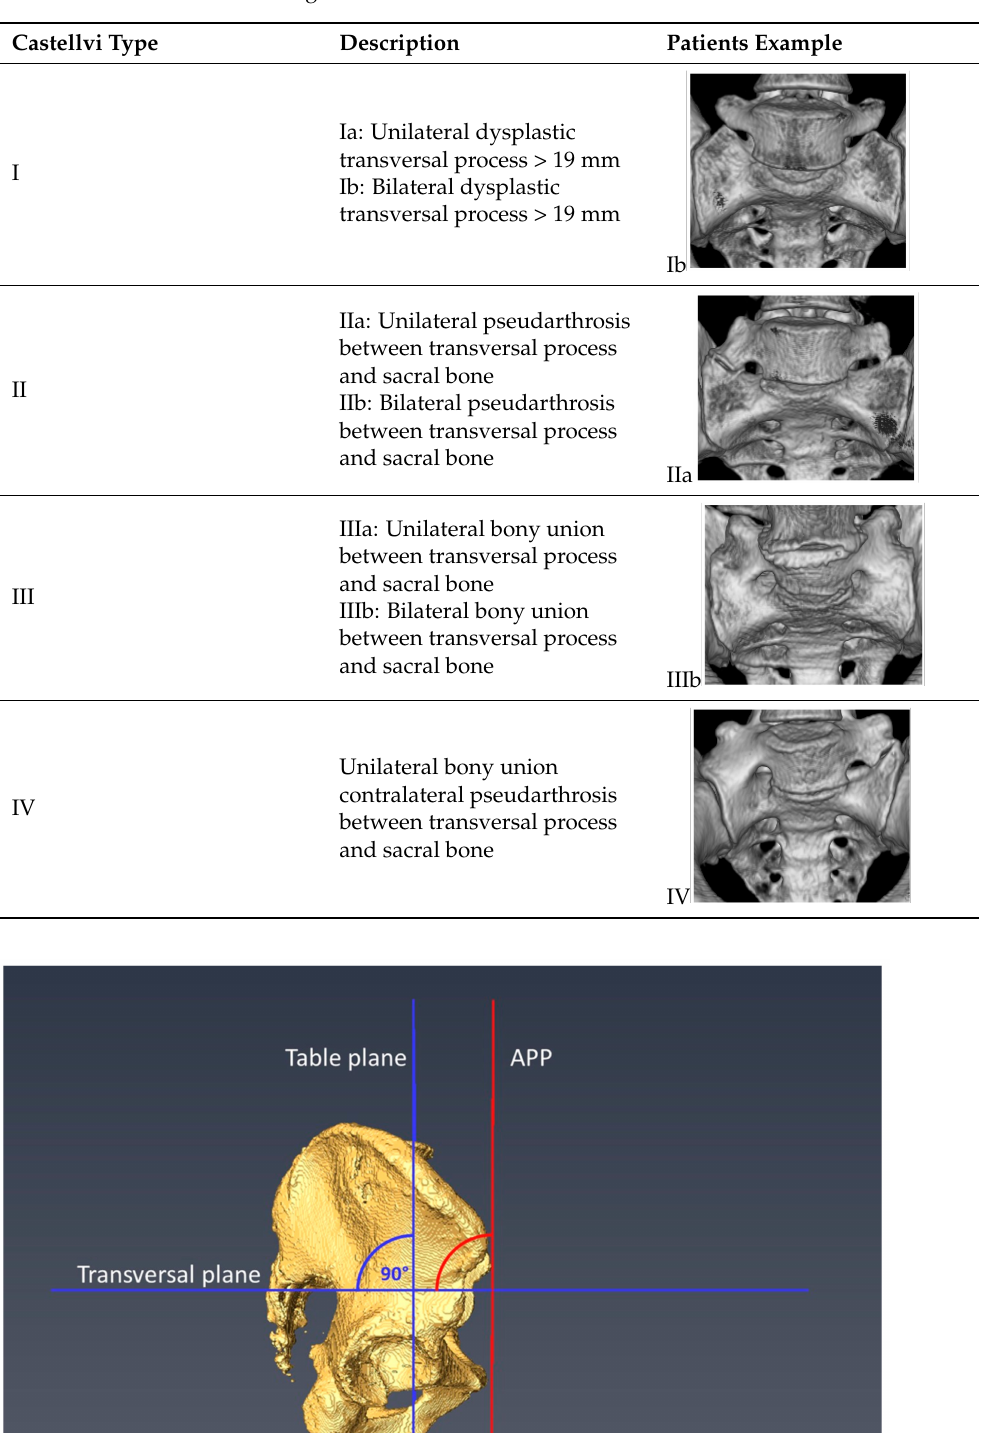
Table 1. Classification according to Castellvi.